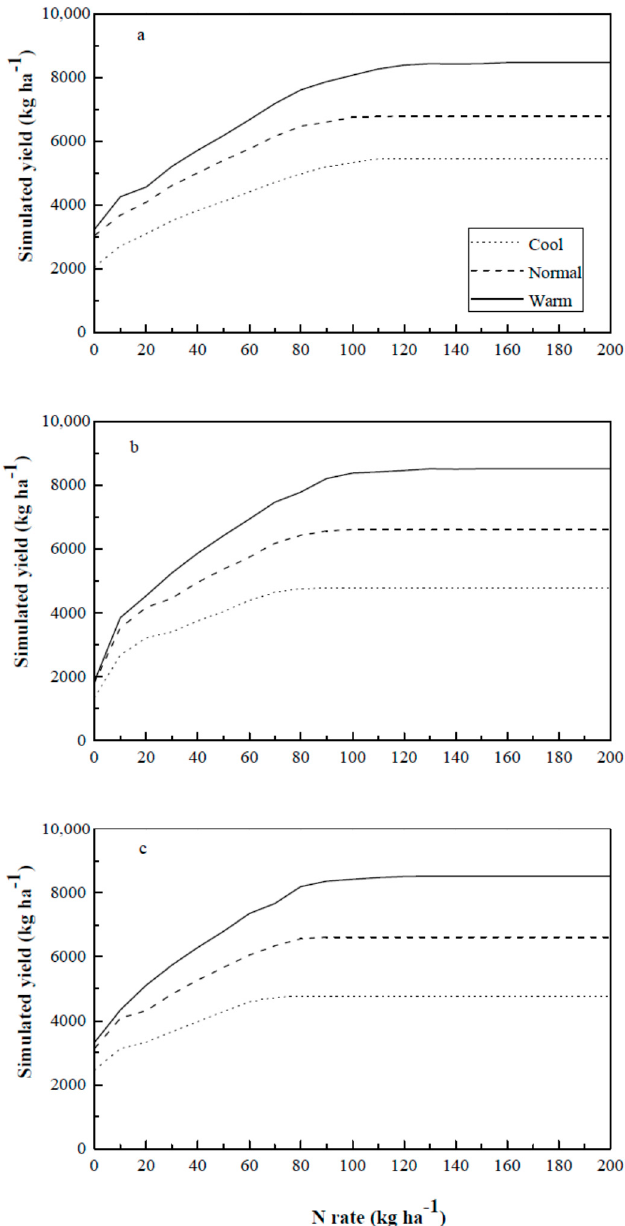
Figure 2. Rice-yield response to N rate for three rice varieties: ( a ) Longjing 21, ( b ) Longjing 31, and ( c ) Kongyu 131 in typical cool-, normal-, and warm-weather years.